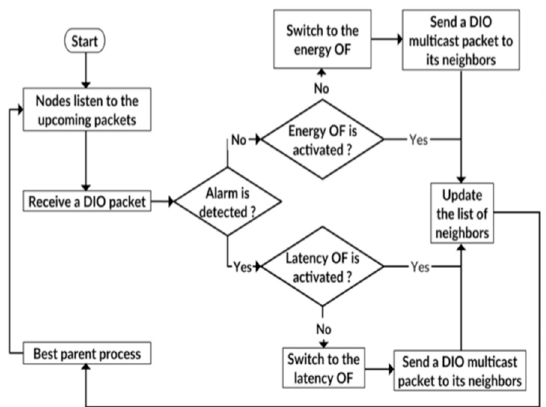
Figure 4. Flowchart of the Cyber-Physical Objective Function (Cyber-OF).